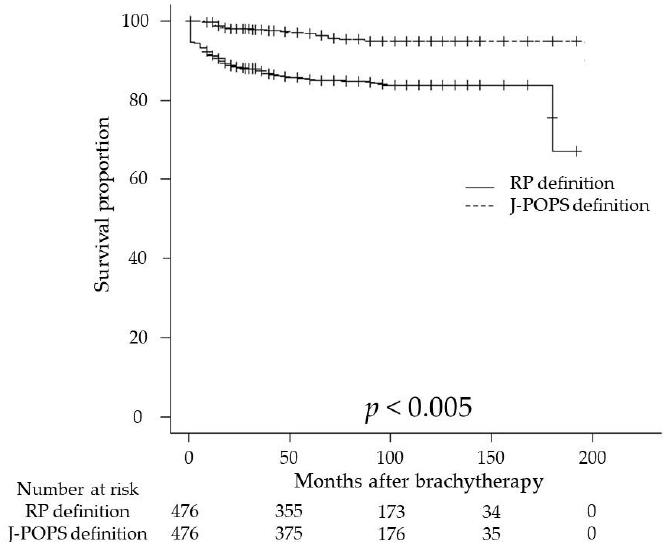
Figure 1. Kaplan–Meier estimates of biochemical recurrence-free survival (BRFS) in patients with prostate cancer who received low-dose-rate brachytherapy (LDR-BT) were calculated according